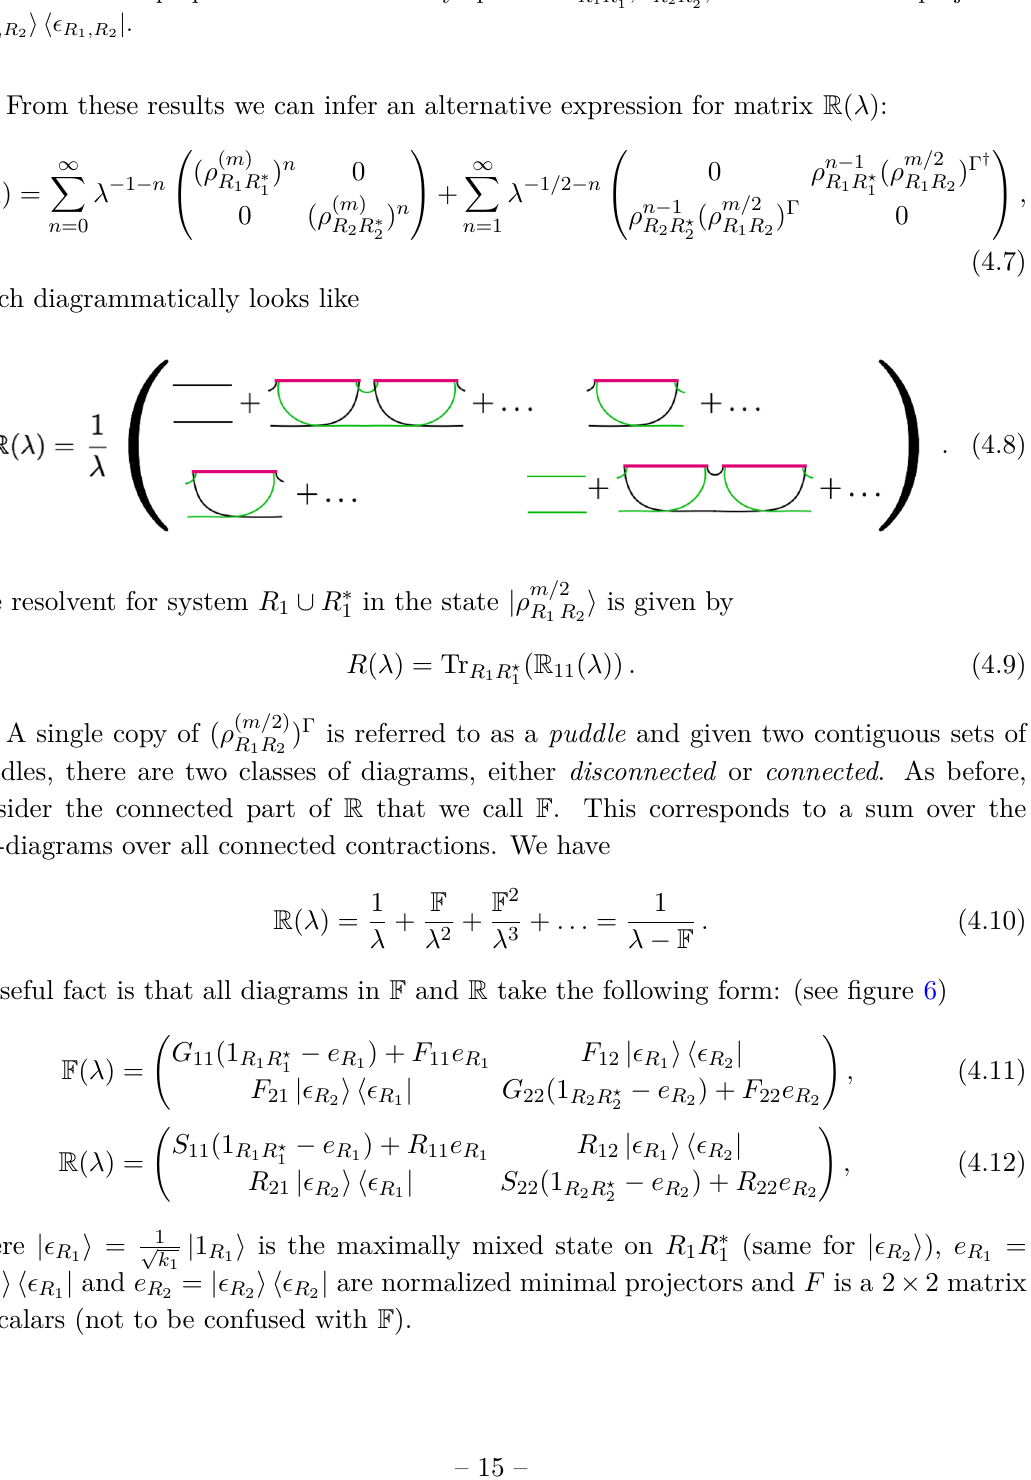
, 1 R , or one of the four projectors 1 R ∗ 1 2 R ∗ 2